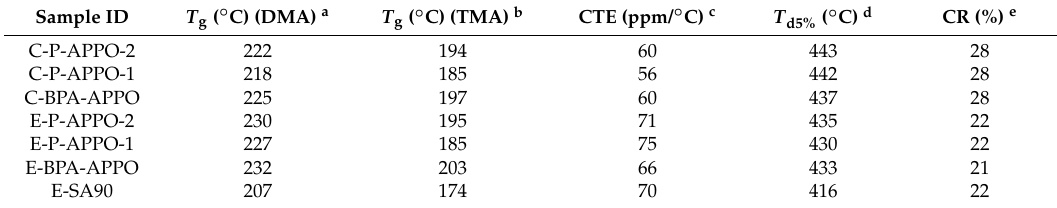
Table 2. Thermal properties of the resulting polybenzoxazine.